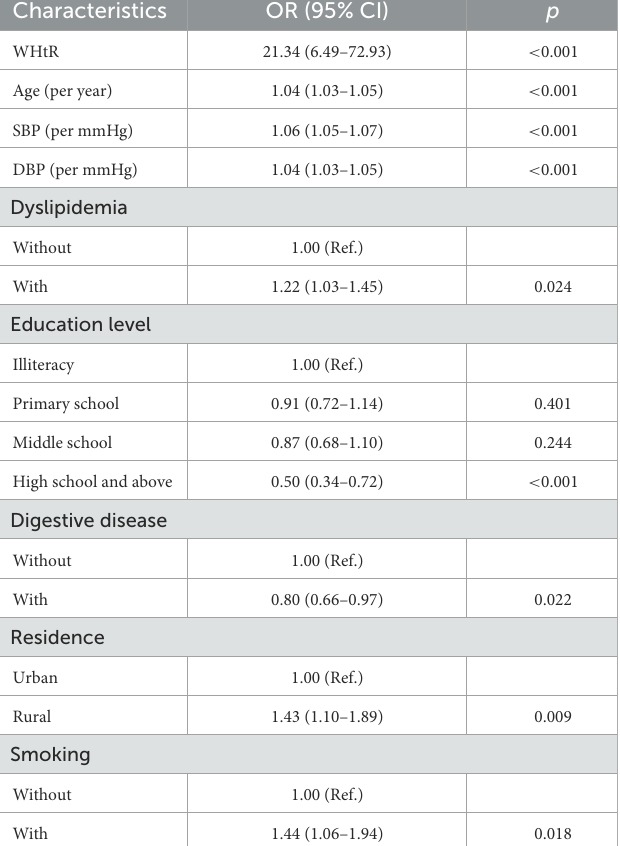
(Supplementary Figure 1). Sensitivity analysis was in accordance with the results (Supplementary Tables